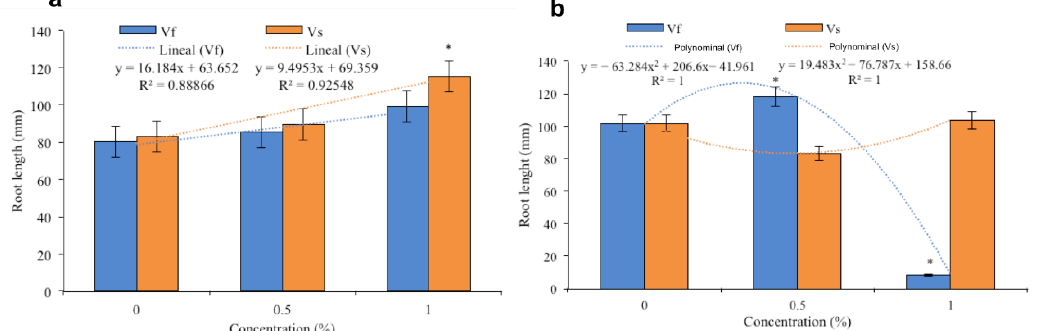
Figure 4. Effects of the aqueous extracts of Verbesina sphaerocephala and Verbesina fastigiata at different concentrations on root length in ( a ) Solanum lycopersicum ( b ) and Cucumis sativus . Columns denoted by an asterisk (*) are statistically different from the control. The values represent the average ( n = 20 seedlings); the bars represent standard error.